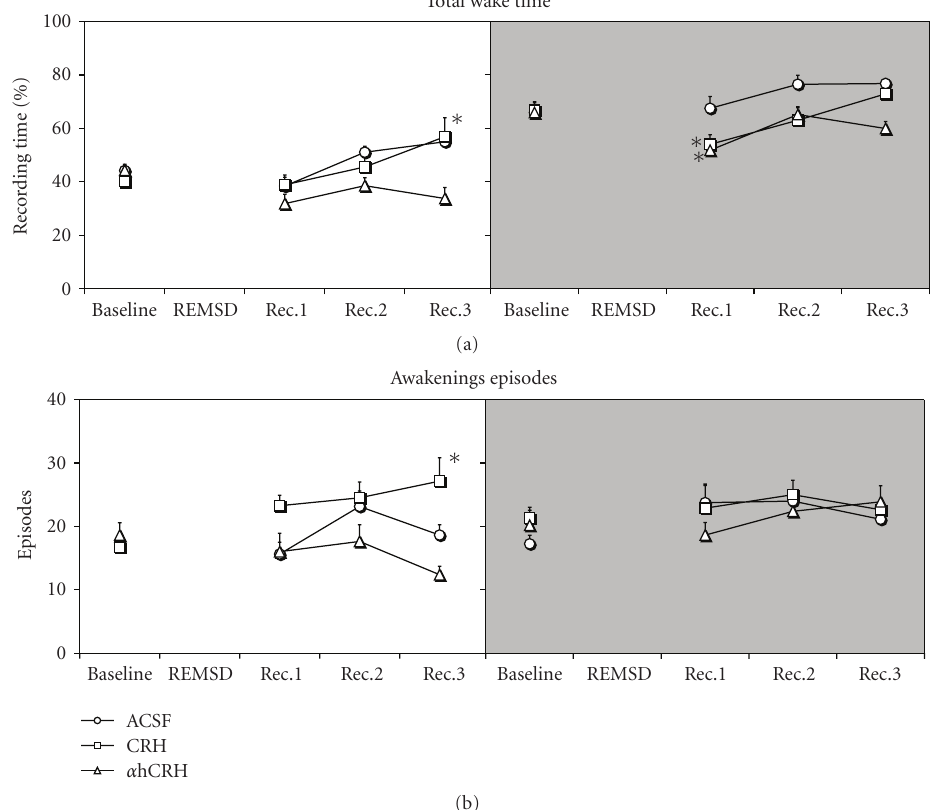
Figure 4: Awake. Data were obtained in recording periods of approximately 11 hours during the light and dark phases. ACSF, artificial cerebrospinal fluid; CRH, corticotrophin-releasing hormone; α hCRH, alpha helical CRH 9 − 41 ; REMSD, 96 hours REM sleep deprivation period; Rec, Recovery period. The white back panels indicate the light phase and the shaded ones, the dark phase. ∗ - di ff erent from baseline. Main e ff ects of day are indicating by connecting lines above the symbols. ANOVA/Newman-Keuls, P ≤ .